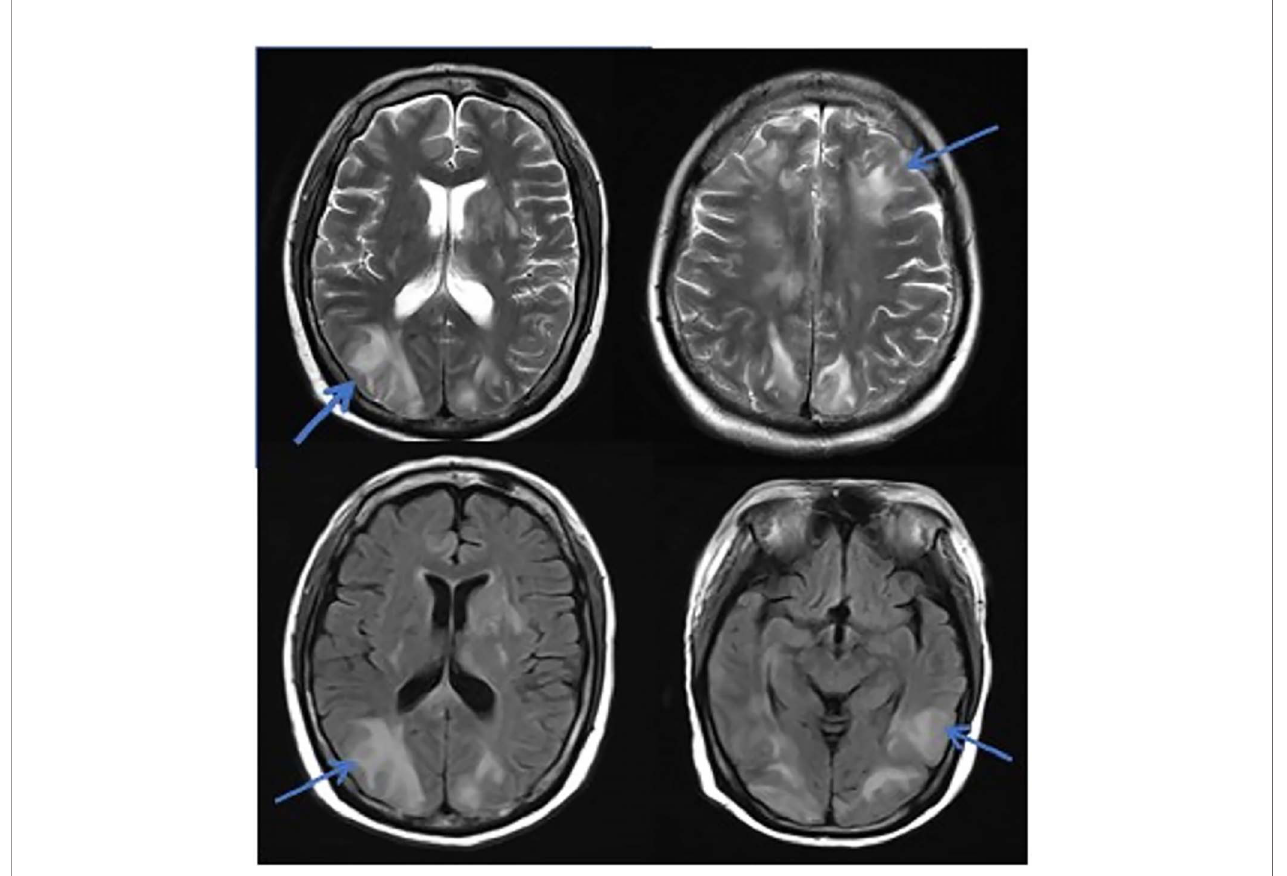
FIGURE 1 | MRI in patients with PRES. The patient diagnosed with PRES showed a patchy low-intensity T1WI on the left occipital lobe, a high-intensity shadow on the T2WI and water pressure image, a high-intensity shadow in the DWI sequence part, unclear borders, and a shallow fi ssion near the